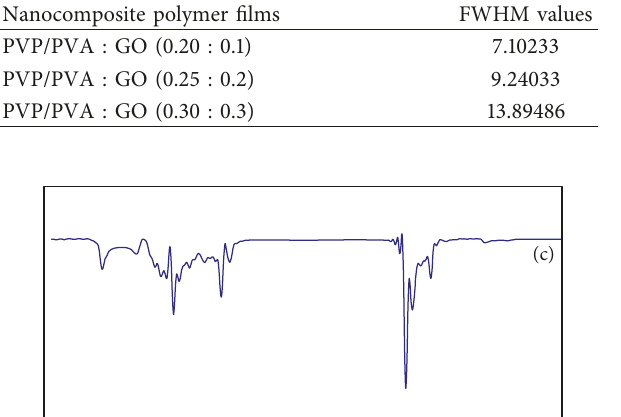
Figure 3: DSC spectra of polymer electrolyte films for different PVP/PVA : GO wt.% ratios of (0.20 : 0.1), (0.25 : 0.2), and (0.30 : 0.3).